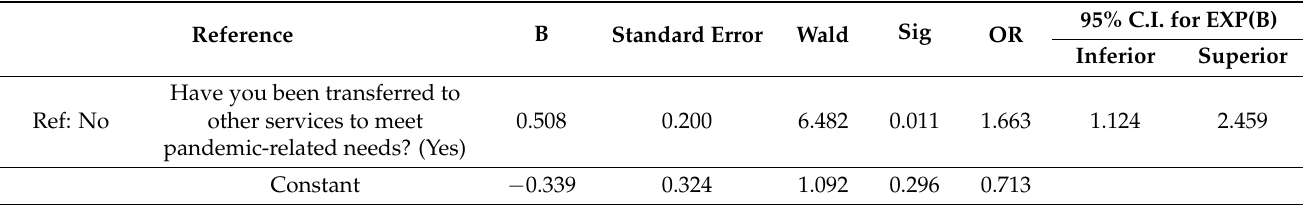
Table 6. Binary logistic regression on the factor influencing the need for psychological support to the greatest